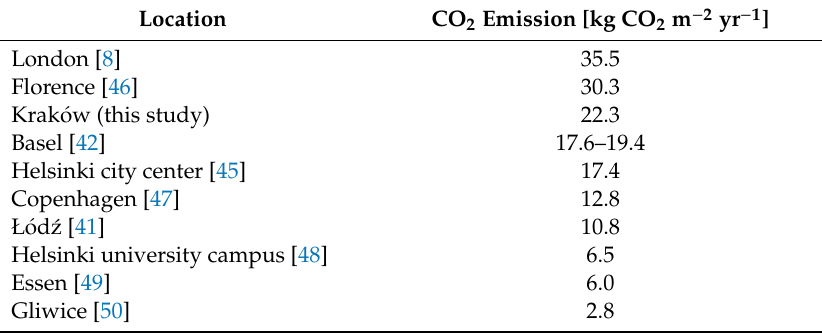
Table 5. CO 2 emissions from European cities reported in the